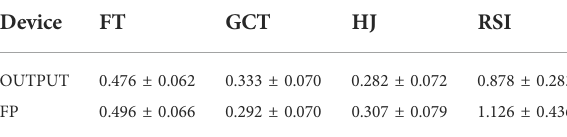
TABLE 2 Means ± SD of the kinematic variables registered by both devices. Device